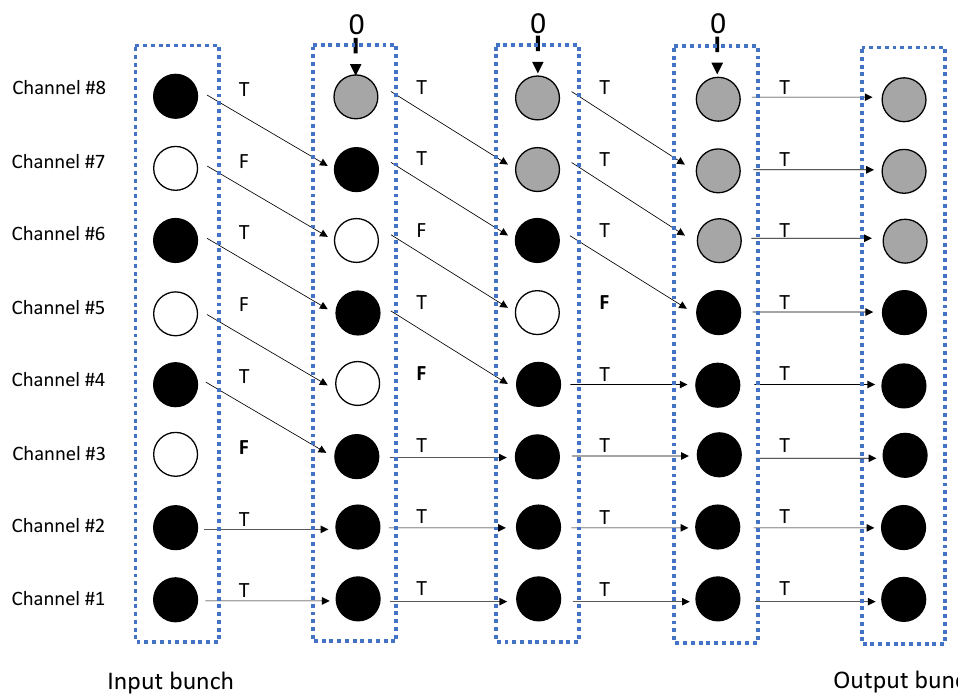
Figure 4. Bunches are defragmented by deleting the dummy samples (white bullets) and retrieving the useful resampled values (black bullets); the topmost positions freed by the data routing operations are filled with zeros (gray